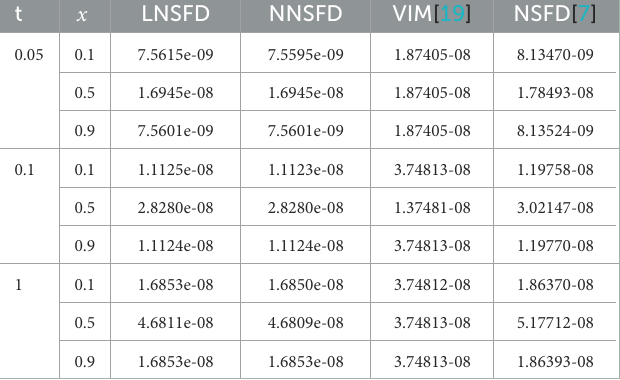
TABLE 3 Comparison of absolute errors for Example 4.1 using the proposed scheme (LNSFD) with results of [7, 19] and NNSFD for ε = 1, α = β = 1, γ = 0.001 at some values of x and t .